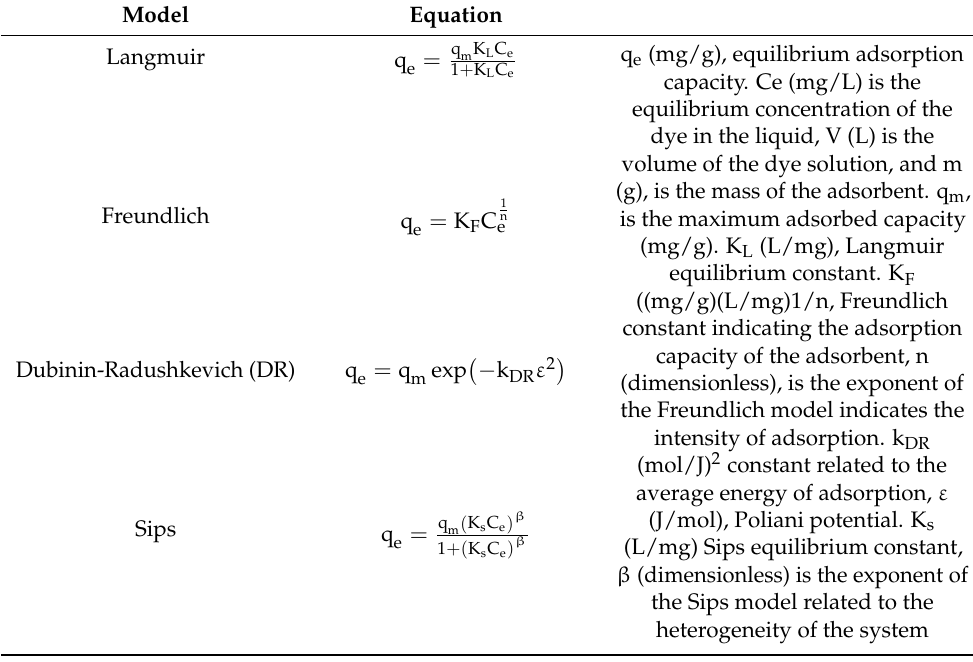
Table 1. Non-linear adsorption isotherm models